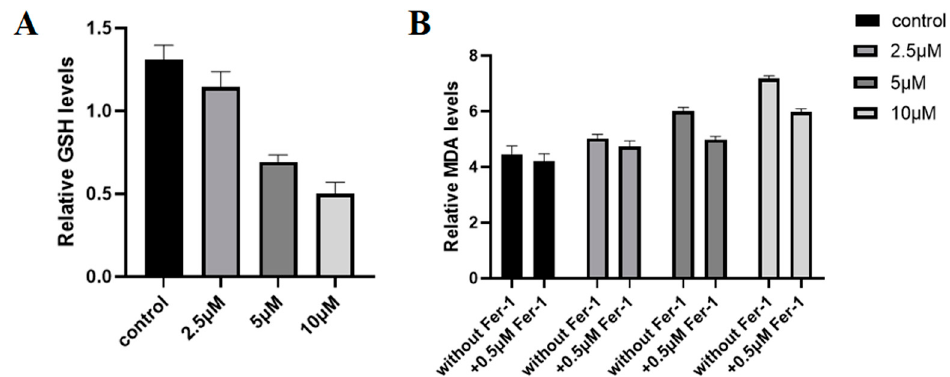
Figure 7. Effects of hybrid A8 on the GSH level ( A ) and MDA level ( B ) of MCF-7 cells; Micro Reduced Glutathione (GSH) Assay Kit was used for GSH detection and Lipid Peroxidation MDA Assay Kit was used for measuring MDA level.